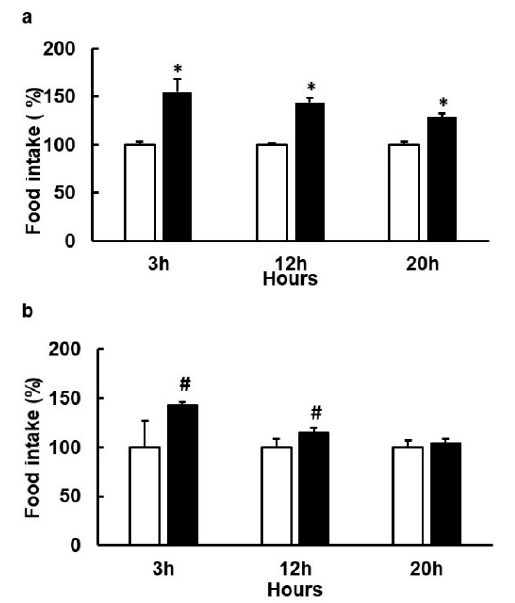
Figure 5. Changes in food intake (FI) induced by acute doses of agonists of bitter taste receptors in female rats. Animals ( n = 8–10 / treatment) were treated one hour before the dark period with an acute dose of epicatechin (234 mg / kg) + epicatechin gallate (14 mg / kg), a whole dose ~0.84 mM (black columns) ( a ); epicatechin (213 mg / kg) + B2 (62 mg / kg), a whole dose ~0.84 mM ( b ). White columns indicate the control group treated with tap water as vehicle. Food intake was measured at the times indicated after the start of the dark period starts (Mean ± SEM). * denotes p < 0.05 vs. control, # denotes p < 0.1 vs. control.